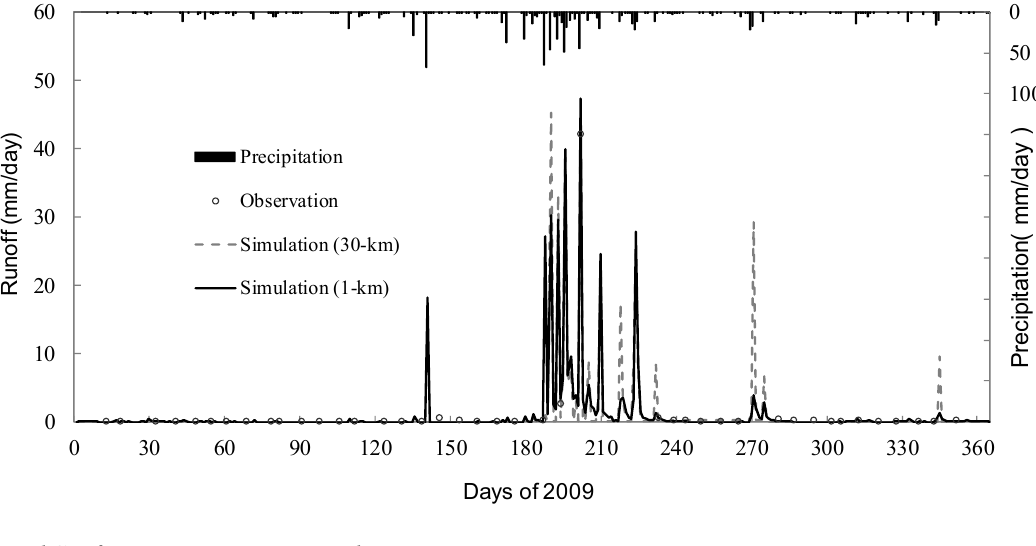
Figure 5. Comparison of daily time series of total runoff simulated from the CoLM at 1-km and 30-km resolutions along with 42 stream flow observations at the Korea Meteorological Administration (KMA) stream gauge station Y-A and the daily observed total precipitation for the study basin in